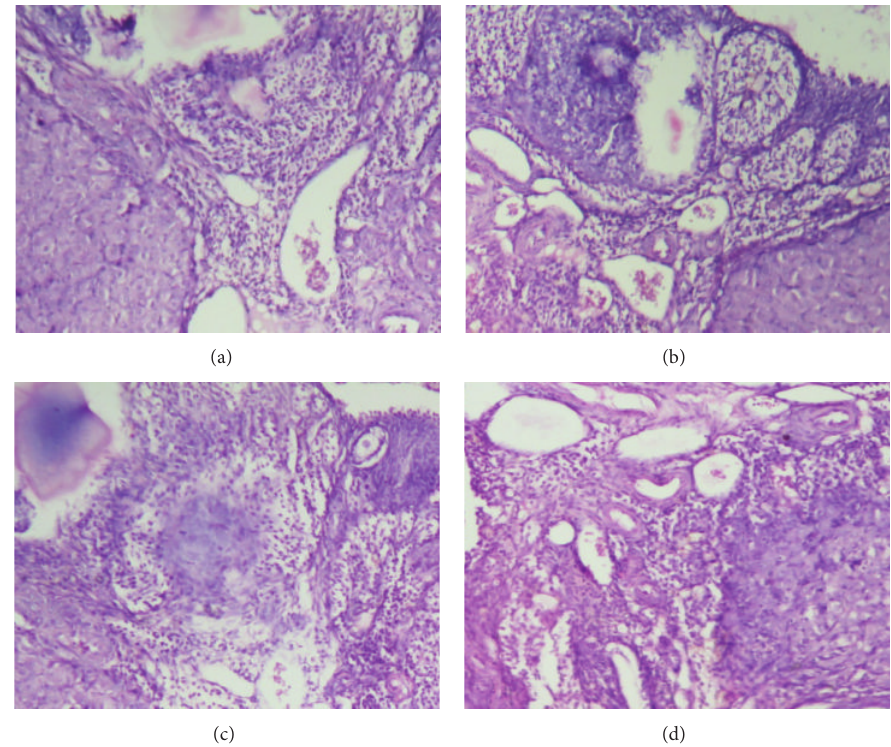
Figure 6: Histological of ovary (H&E, 100x) of control and experimental group of animals. (a) Section of ovary from control animal showed normal small follicles and large follicles; ((b), (c) and (d)) ovary from OSE 200, 400, and 800 mg/kg treated exhibit normal small follicles and large follicles in the